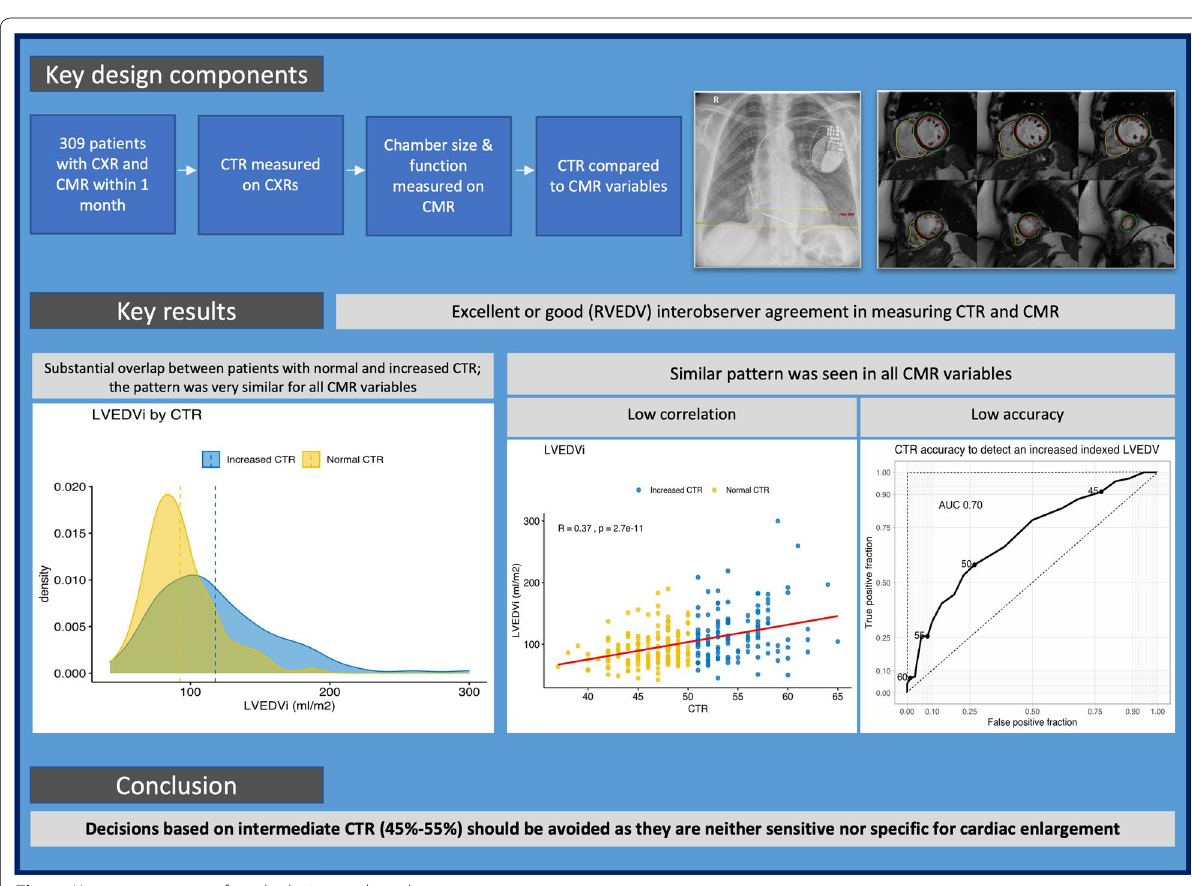
Fig. 1 Key components of study design and results